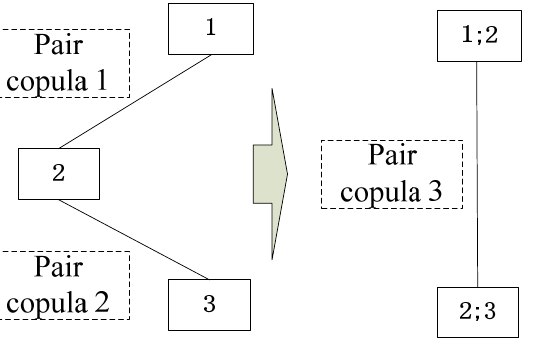
Figure 2. Diagram of three reservoir pair-copulas with canonical-vine structure.